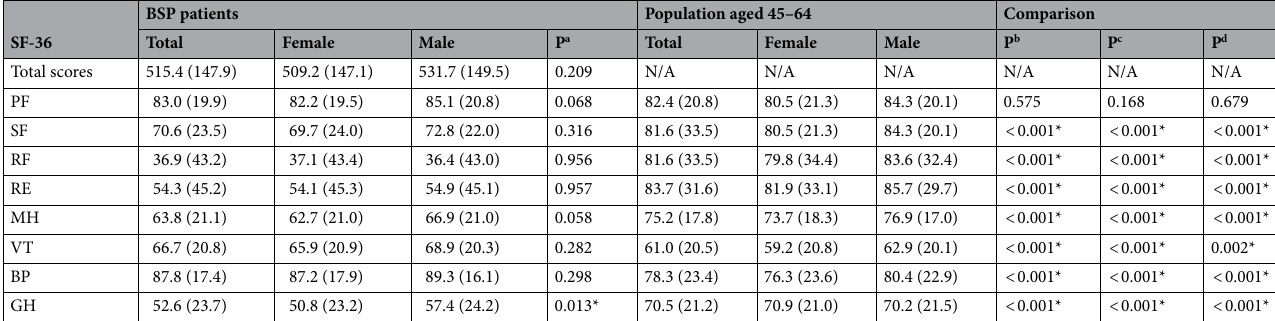
Table 3. Quality of life between female and male patients with primary blepharospasm. PF, physical functioning; RF, role limitation caused by health problems; BP, bodily pain; GH, perception of general health; VT, Vitality; SF, social functioning; RE, role limitations due to emotional health problems; MH, mental health. *Significant difference; P a female BSP patients vs. male BSP patients; P b female BSP patients vs. female population aged 45 to 65 years old; P c male BSP patients vs. male population aged 45 to 65 years old; P d total BSP patients vs. the population aged 45–65 years